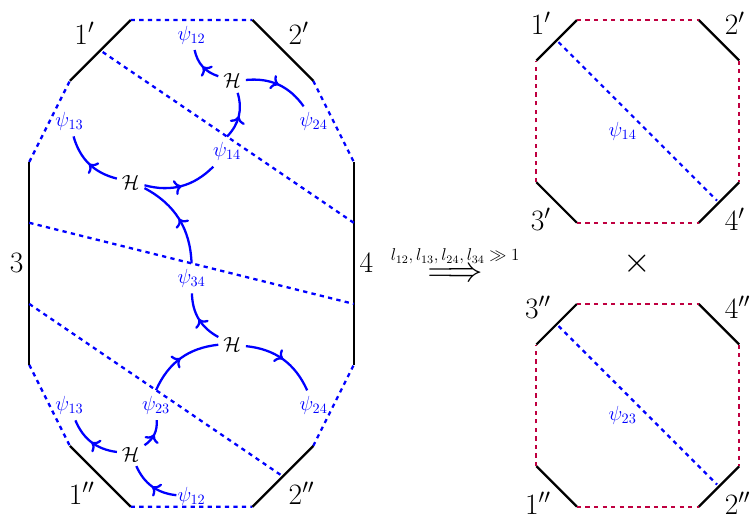
Figure 2 . Sequence of transitions cause by acting with hexagon operators a Boltzmann factor e (cid:0) E ij l ij when propagating through the bridge connecting operators i and j . A sequence of transitions such as 12 H